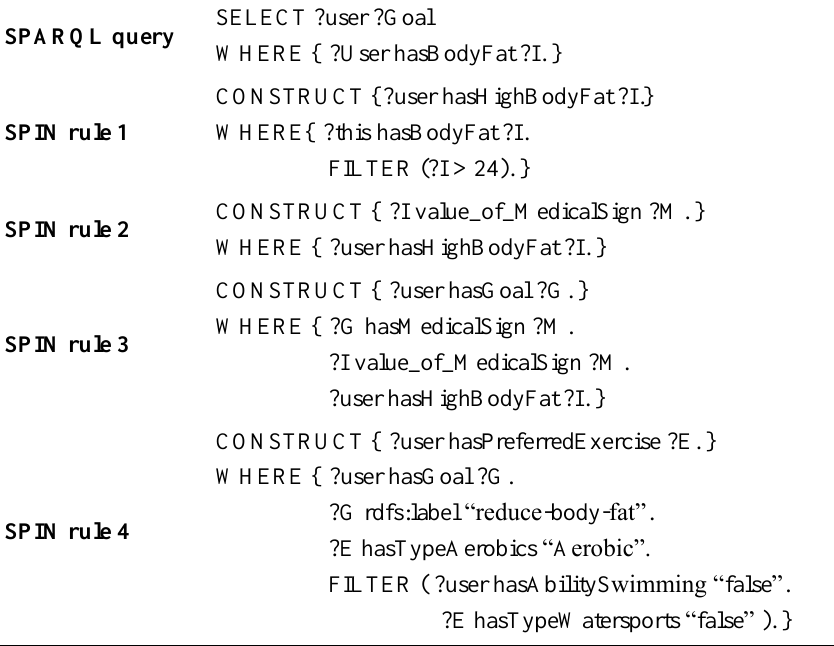
Table 5. A simple illustration for the inference